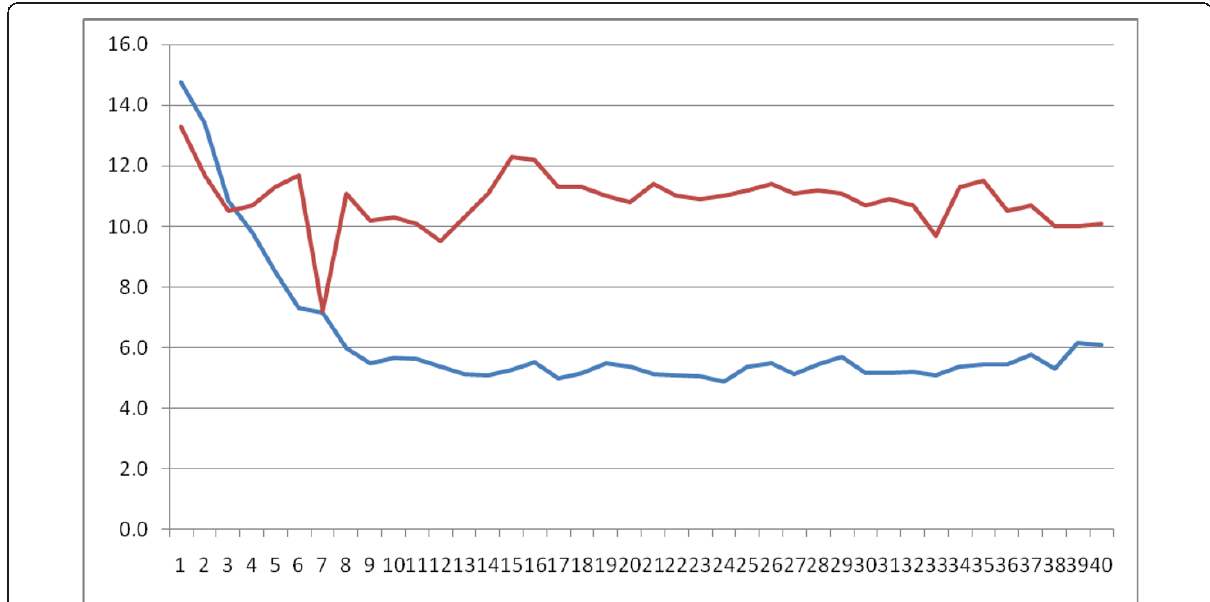
Figure 2 Average RR for Practitioner (blue) and Subjects (red) during Non-tactile NVCC over 10 minute intervention (40 15 second averages) . Correlation, r = 0.55, P <